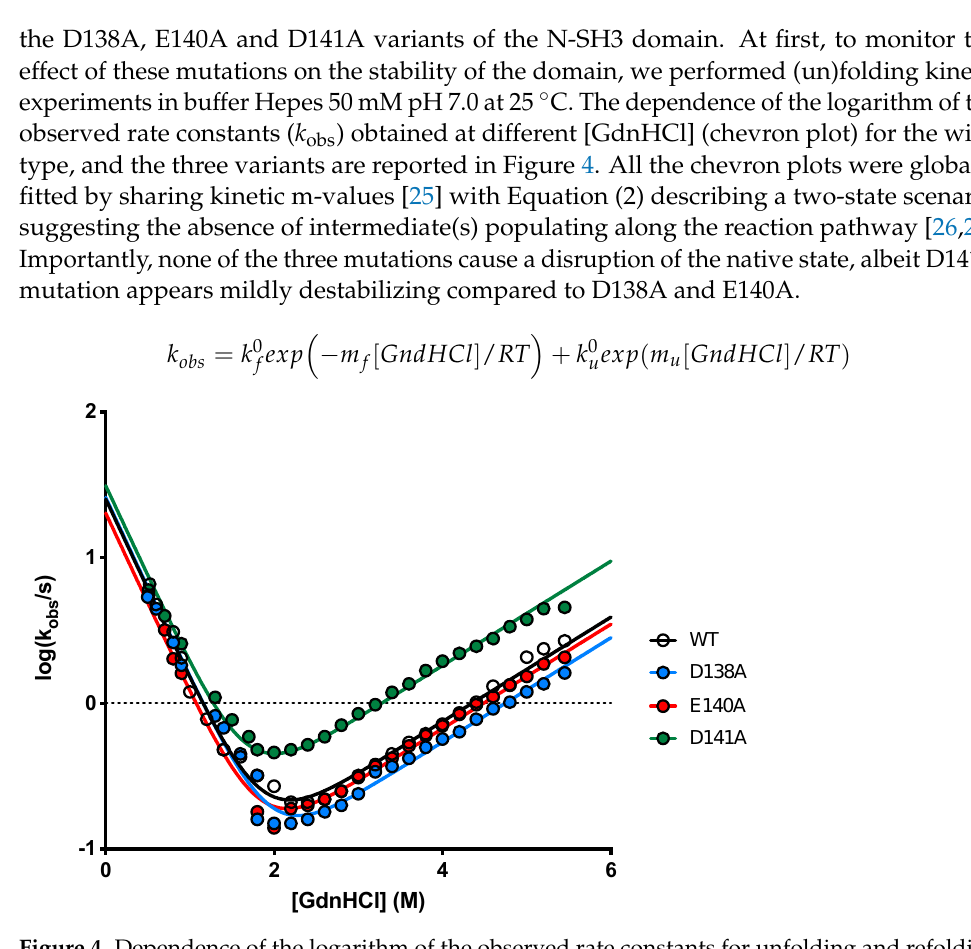
Figure 4. Dependence of the logarithm of the observed rate constants for unfolding and refolding experiments as a function of [GdnHCl] for WT, D138A, E140A and D141A (see legend) obtained in buffer Hepes 50 mM pH 7.5 at 25 °C. Data were globally fitted by sharing kinetic m-values. Lines are the best fit to an equation describing a two-state folding mechanism. WT— k f = 25.3 2.0 s −1 , k u = 0.027 0.002 s −1 ; D138A— k f = 25.9 2.2 s −1 , k u = 0.019 0.001 s −1 ; E140A— k f = 20.2 1.6 s −1 , k u = 0.024 0.001 s −1 ; D141A— k f = 31.2 2.7 s −1 , k u = 0.066 0.004 s −1 ; globally shared m-values—m f =